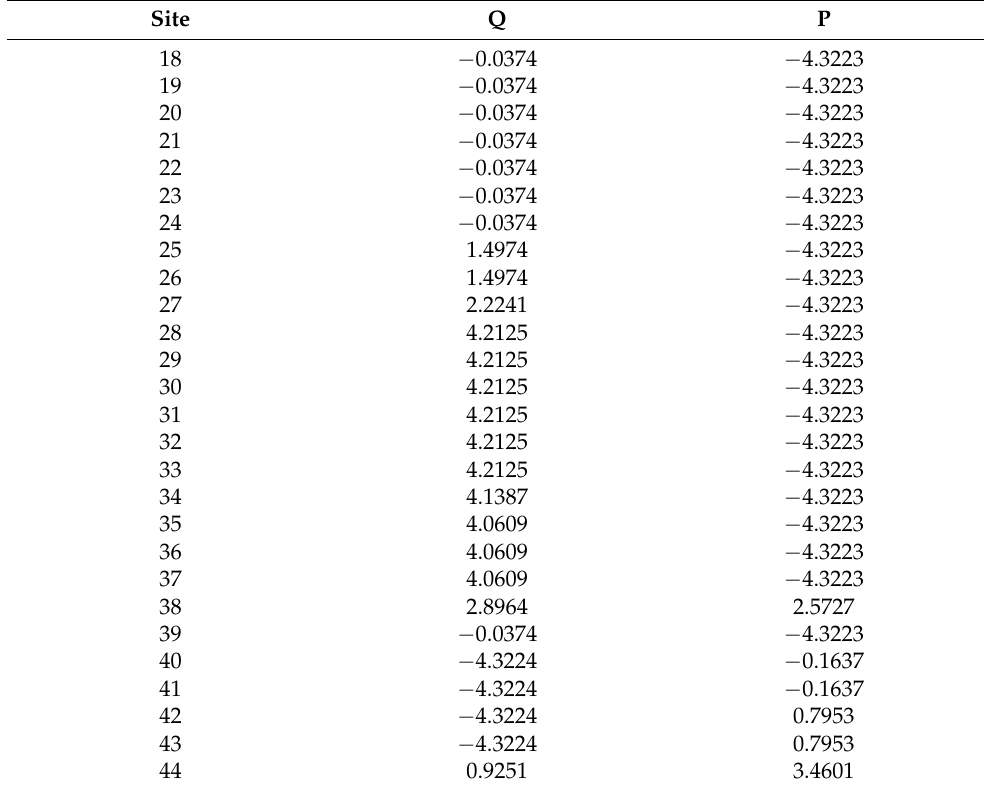
Table 4. Part of the 20 × 3156 position weight matrix obtained with default options for pseudocounts and background frequencies in DAMBE [40]. Only sites 18 to 44 from 3156 aligned sites are shown, with only two amino acids (Q and P) out of 20. Site numbers are as in the alignment in Figure 3A. Site Q